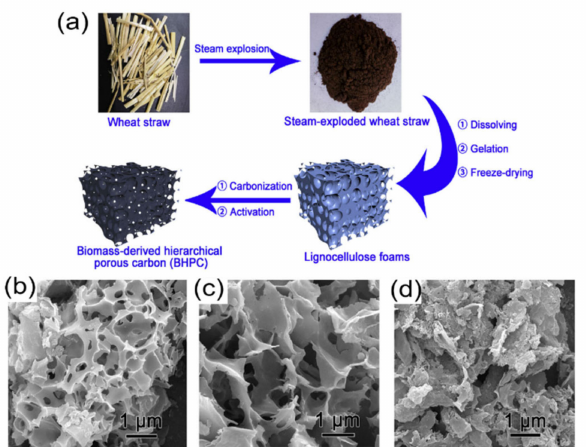
Figure 4. ( a ) Scheme of preparation of the biomass-derived hierarchically porous carbon under different conditions, ( b – d ) SEM images of different biomass-derived hierarchically porous carbons. Figure reproduced and adapted from reference [38] with permission from Elsevier,